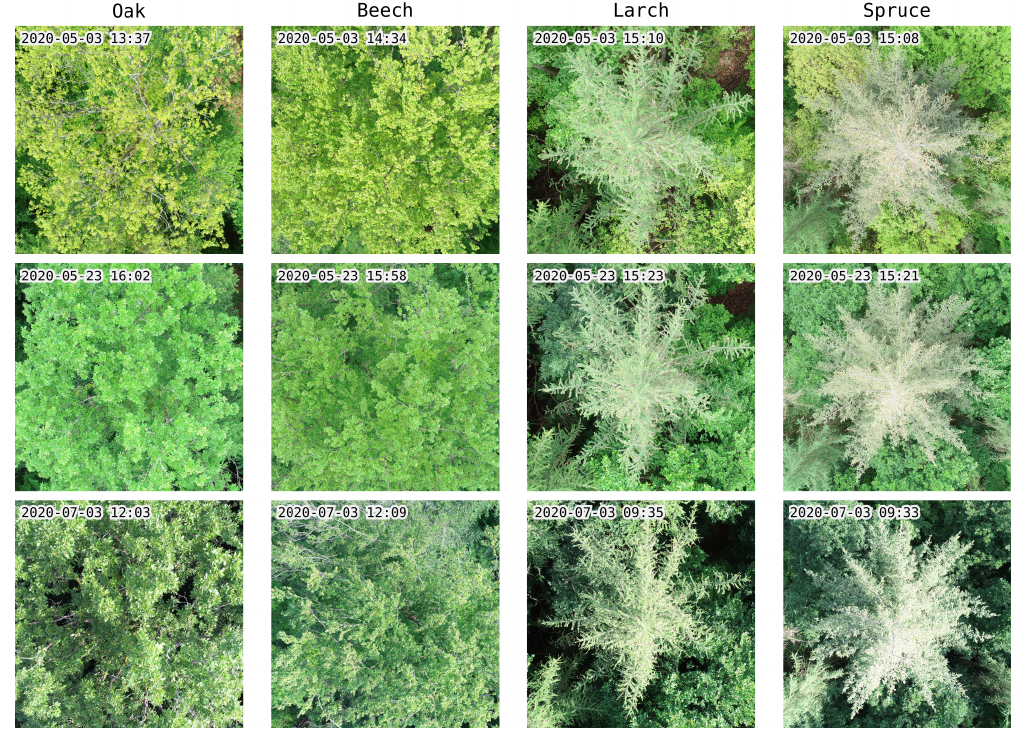
Figure 2. Exemplary UAV photos of the four tree species considered in this study. For each category the same individual tree is shown at different flight dates, weather conditions and phenological stages. Table 1. List of UAV flights conducted within the scope of this study. Photo counts indicate the amount of all photos taken per flight date. Tile counts refer to the number of actually tagged tiles per